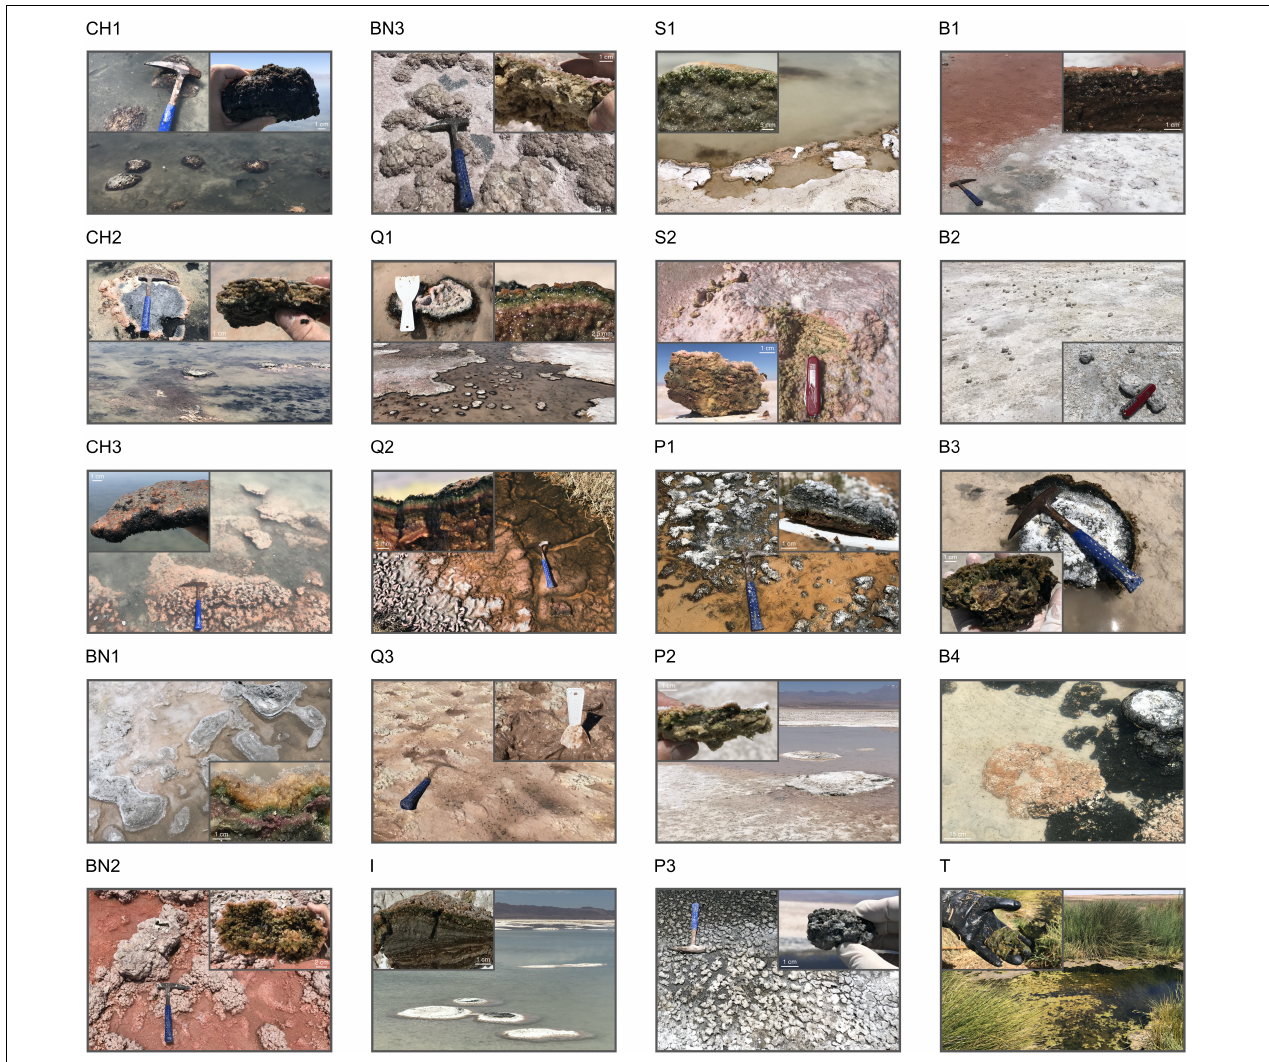
FIGURE 2 | General views of the AMEs discovered in Salar de Atacama. CH1, CH2 and CH3, Microbialites from Laguna Chaxa; BN1, BN2 and BN3, Endoevaporites from Laguna Barros Negros; Q1 and Q2, Microbial mats from Aguas de Quelana; Q3, Sediment-associated microbial community from Aguas de Quelana; I, Microbialite from Laguna Interna; S1, Microbial mat from Laguna Salada; S2, Microbial community within an Andean flamingo mound nest from Laguna Salada; P1 and P2, Microbial mats from Laguna La Punta; P3, Microbialite from Laguna La Punta; B1, Microbial mat from Laguna Brava; B2, B3 and B4, Microbialites from Laguna Brava; T, Floating biofilm from